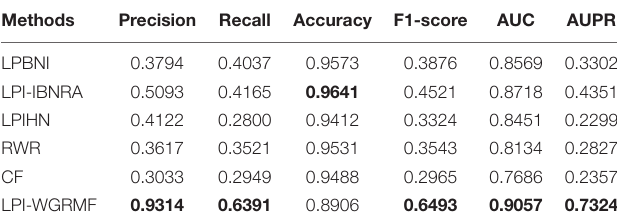
FOrkhead boX protein D2-Adjacent Opposite Strand RNA 1 (FOXD2-AS1), Small Nucleolar RNA Host Gene 3 (SNHG3), and Pre-mRNA-Processing Factor 31 (PRPF31),